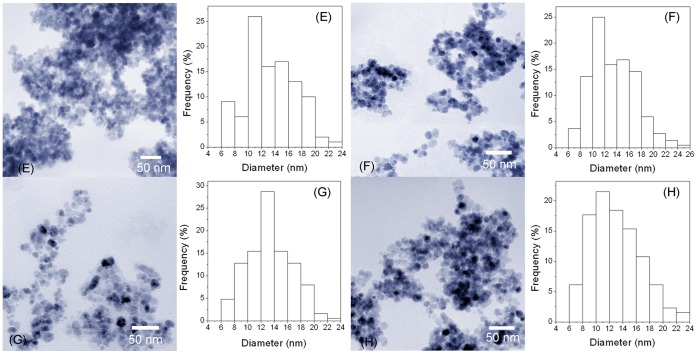
TEM images of Fe3O4 (E), C3-Fe3O4 (F), C8-Fe3O4 (G), and C18-Fe3O4 (H) nanoparticles immobilized with lipase.